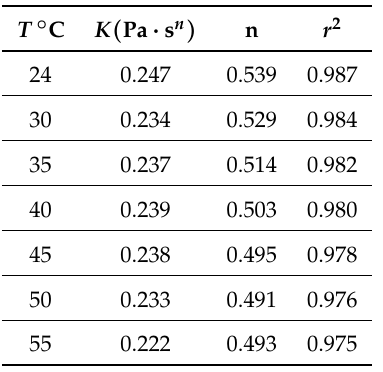
Figure 4. Shear rate vs. Shear stress curves of fruit juice at several temperatures. Table 2. Power-Law equation fitting parameters of the fruit juice.